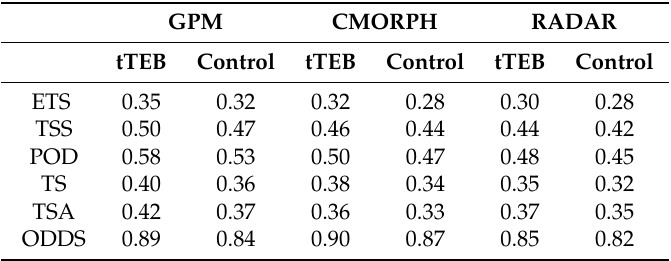
Table 8. Performance measures described in Section 6 for the rainfall results of the tTEB, control experiments, rainfall estimates of satellites (Global Precipitation Measurement (GPM) and CMORPH) and rainfall estimates the weather radar. GPM CMORPH RADAR tTEB Control tTEB Control